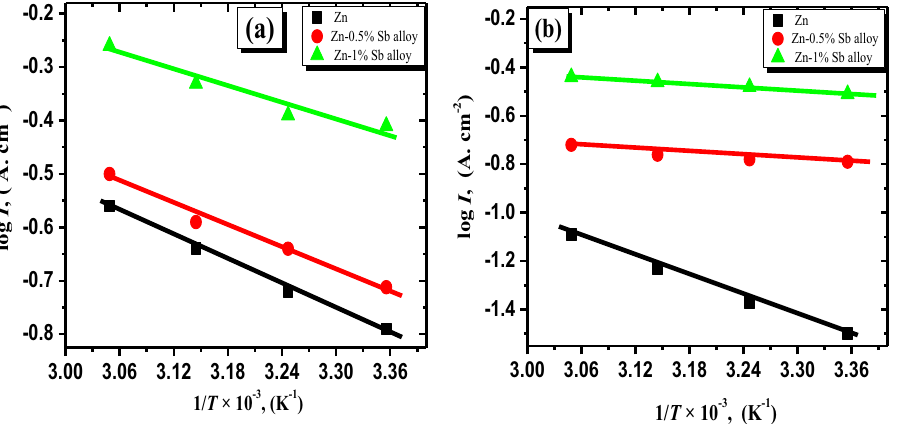
Figure 3. Arrhenius plots for Zn and Zn-Sb samples in the alkaline solution at varied temperatures and fixed potentials of − 1.27 V ( a ) and + 0.8 V ( b ).